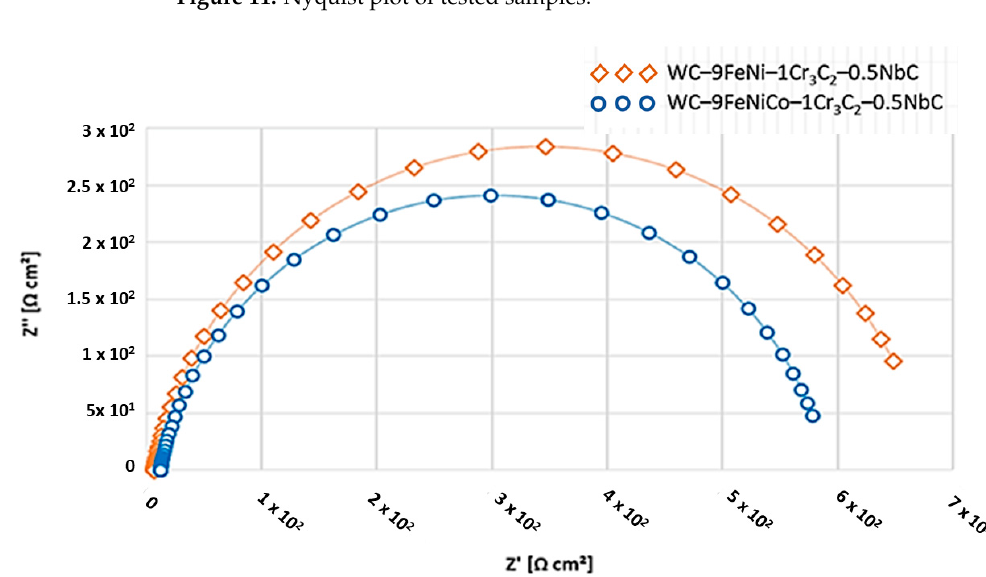
Figure 11. Nyquist plot of tested samples.